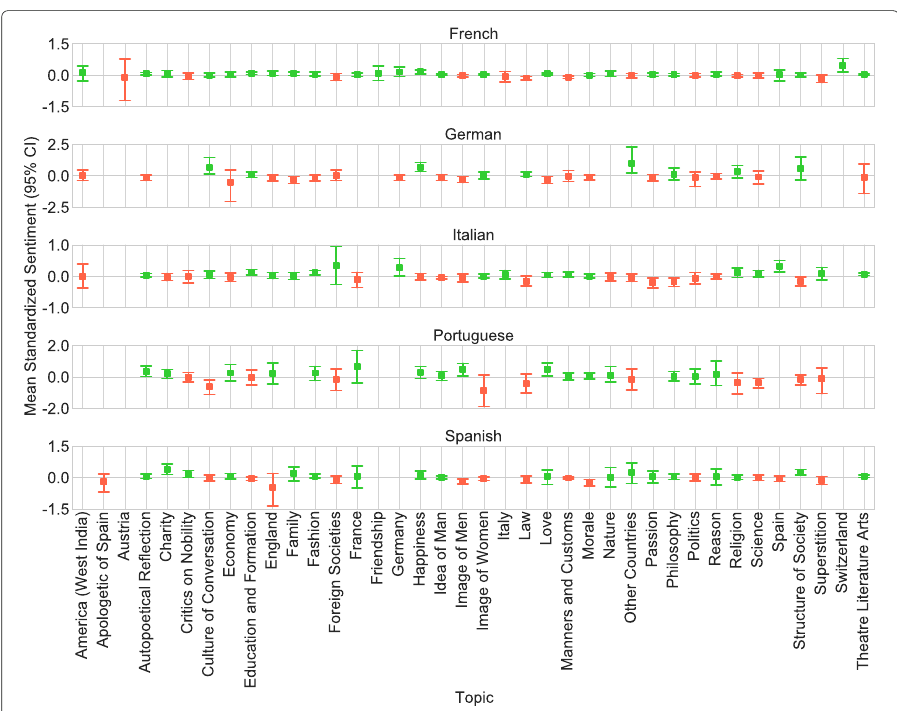
observe significant differences across